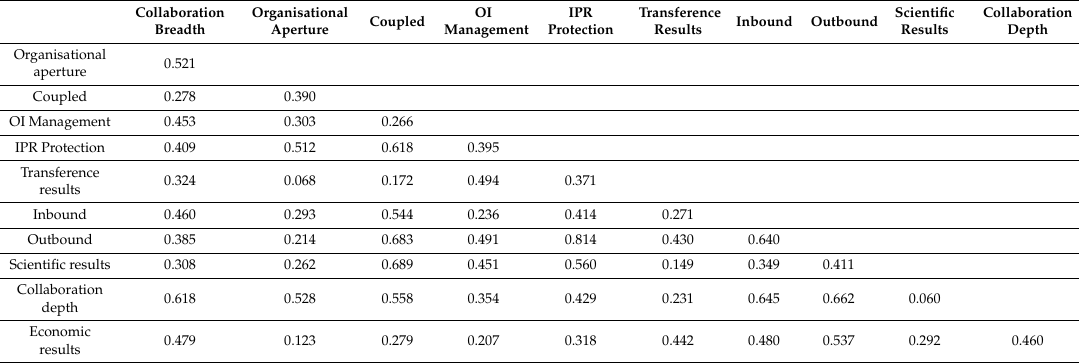
Table 8. Heterotrait–Monotrait (HTMT) criteria.